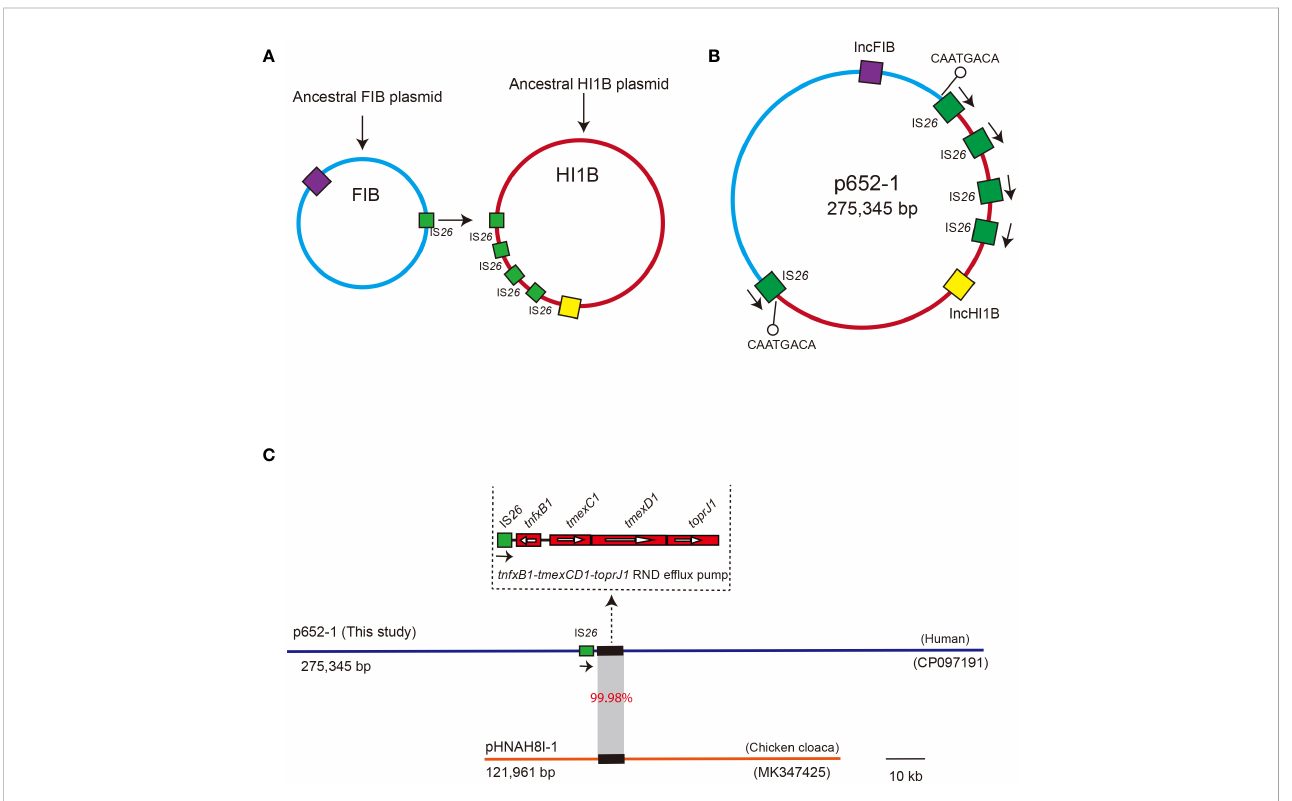
FIGURE 5 Proposed diagram for the formation of the co-integrate p652-1 plasmid. (A) The ancestral IncFIB plasmid and IncHI1B plasmid. Replicons are shown as purple and yellow fi lled boxes, respectively. IS 26 copies are shown as green fi lled boxes. (B) A co-integrate containing IncFIB-IncHI1B sequences via an IS 26 -mediated transposition event. Positions of the 8-bp target site duplication (TSD) adjacent to two IS 26 are indicated by a black line with a hollow circle. Directions of IS 26 are indicated via black arrows. (C) Plasmid comparison between p652-1 (this study, CP097191) and pHNAH8I-1 (MK347425). Plasmid backbones are shown as thick, blue and red lines, with one copy of IS 26 shown as green fi lled boxes with directions indicated by black arrows. Thick lines indicate the tmexCD1 - toprJ1 RND ef fl ux pump-encoding gene cluster. Gray shading indicates the region with 99.98%